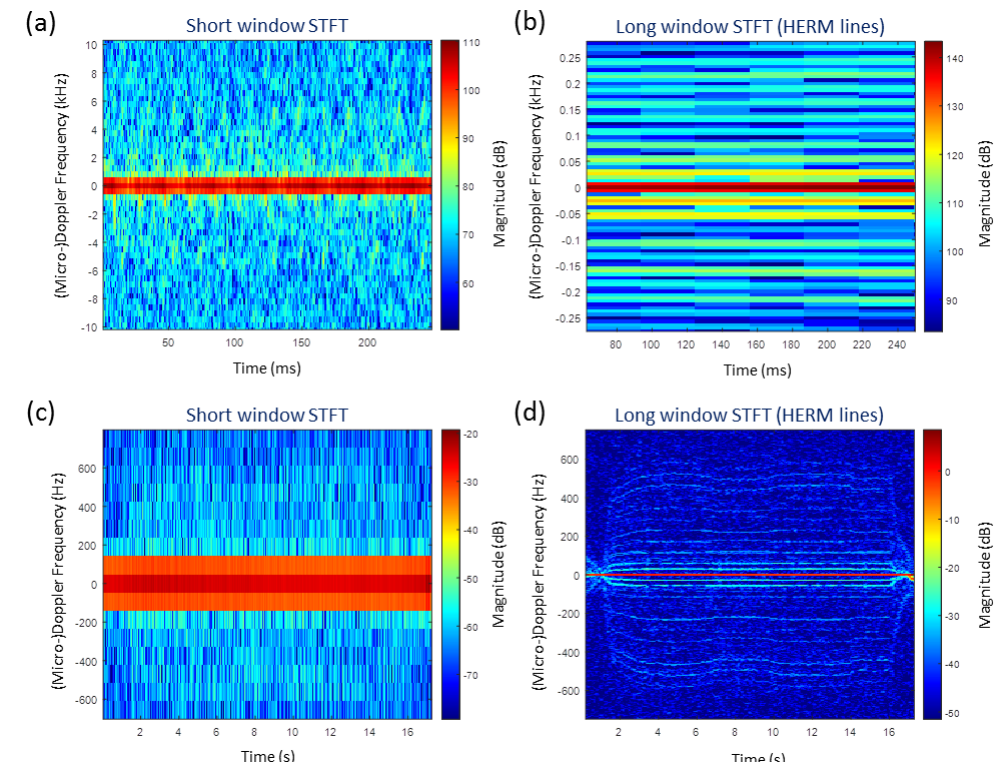
Figure 5. Spectrogram with a low signal to noise ratio of the coaxial helicopter measured by W-band radar using ( a ) short window STFT and ( b ) long window STFT. Spectrogram of the coaxial helicopter measured by C-band radar with insufficient PRF to capture all individual blade flashes using ( c ) short window STFT and ( d ) long window